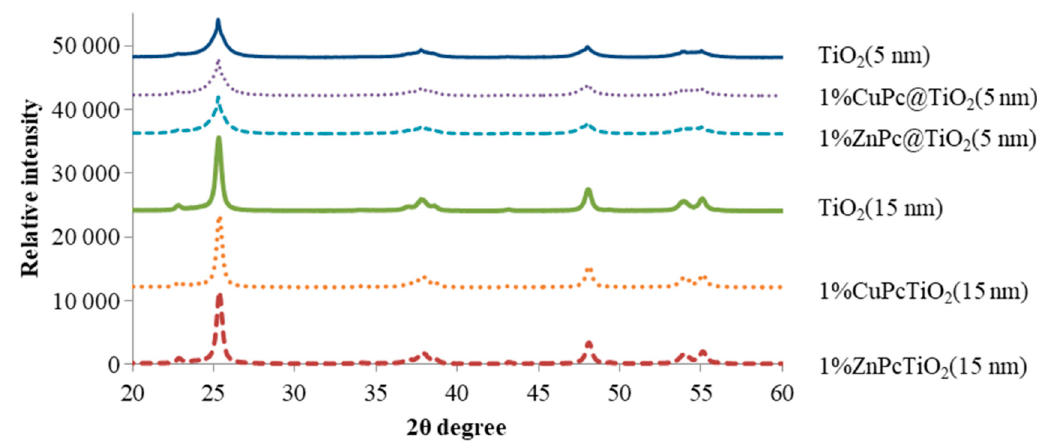
Figure 3. X-ray powder diffraction (XRPD) patterns of the prepared materials.